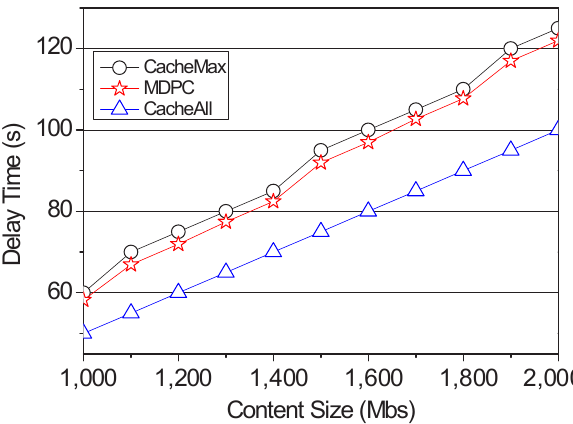
Figure 5. The delay time impacted by content